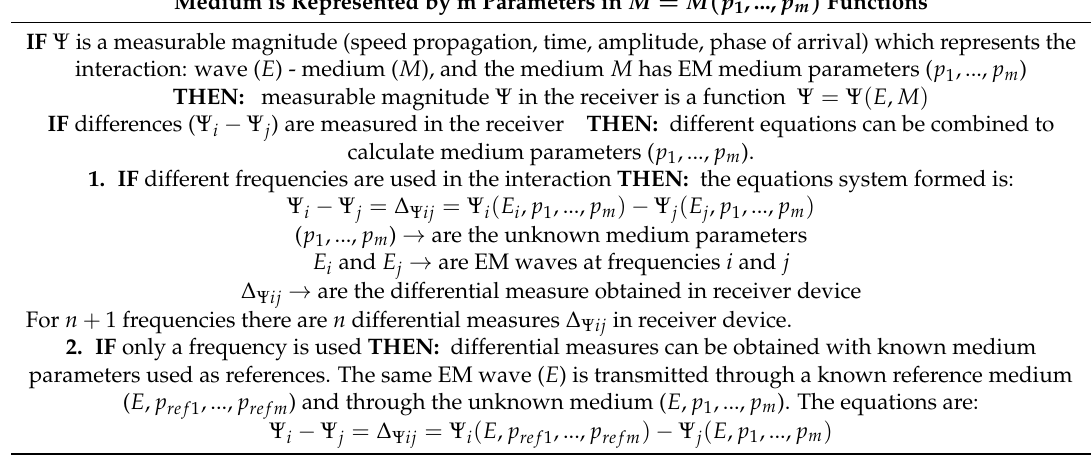
Figure 2. Differential method with different frequencies. The differential measures in the receiver incorporate information. Time synchronization is not necessary. The differential method proposed can also use a single frequency inducing different medium conditions. Table 1. Theoretical differential method